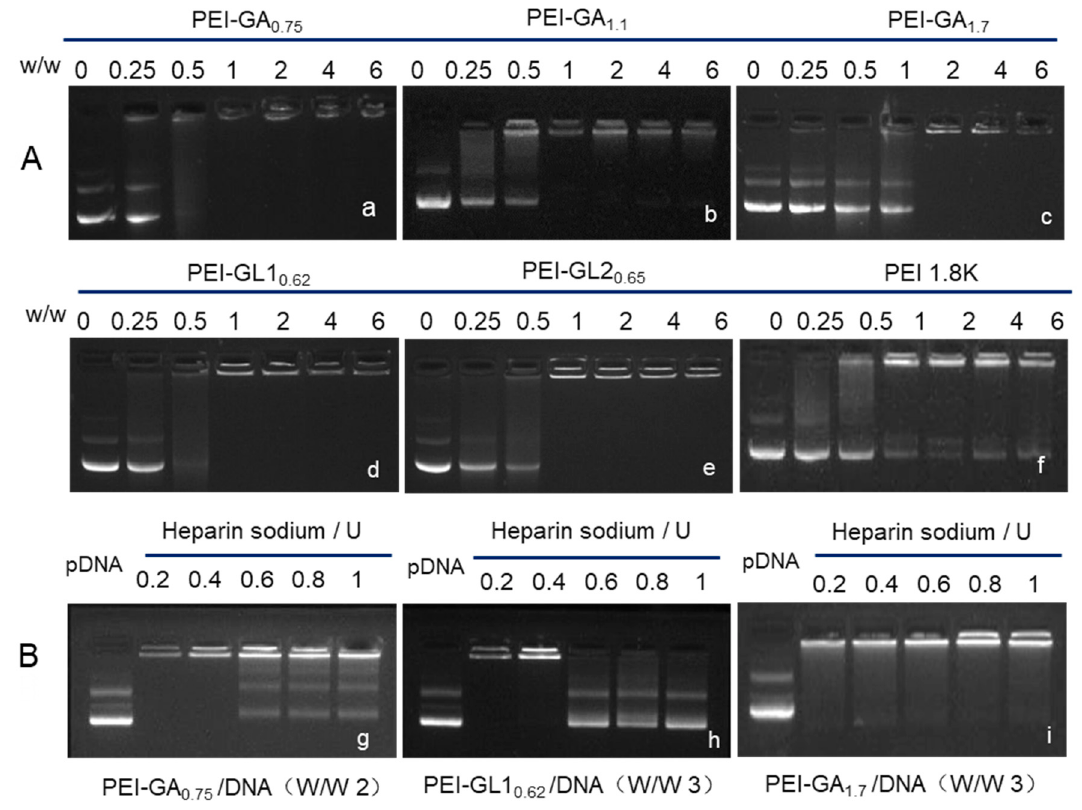
Figure 2. Agarose gel assay. ( A ) pDNA binding ability assay, PEI-GA (GL)/pLUCI polyplexes were prepared at various weight ratios (W/W) from 0.25 to 6 with fixed amount of pDNA (0.4 μ g, pGL4.13 luciferase plasmid) in pH 7.4 HEPEs solution. ( B ) Heparin competitive binding assay. 0.2–1 U heparin sodium were added in newly prepared PEI-GA 0.75 /pDNA (W/W 2), PEI-GL1 0.62 /pDNA (W/W 3) and